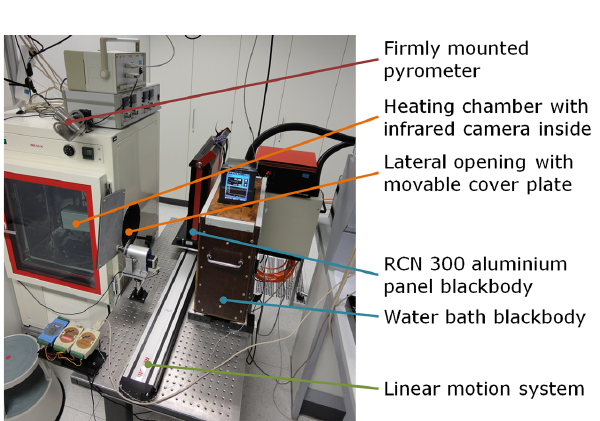
Figure 4. Positions of the temperature sensor sites inside the cam- era housing and the detector. TP 1 (red) is placed on the front plate carrying the optics. TP 2 (green) is located on the front side of the optical channel. TP 3 (blue) is placed close to the detector and the signal processing unit on the back side of the optical channel. The fourth site is located inside the sensor array itself (violet).